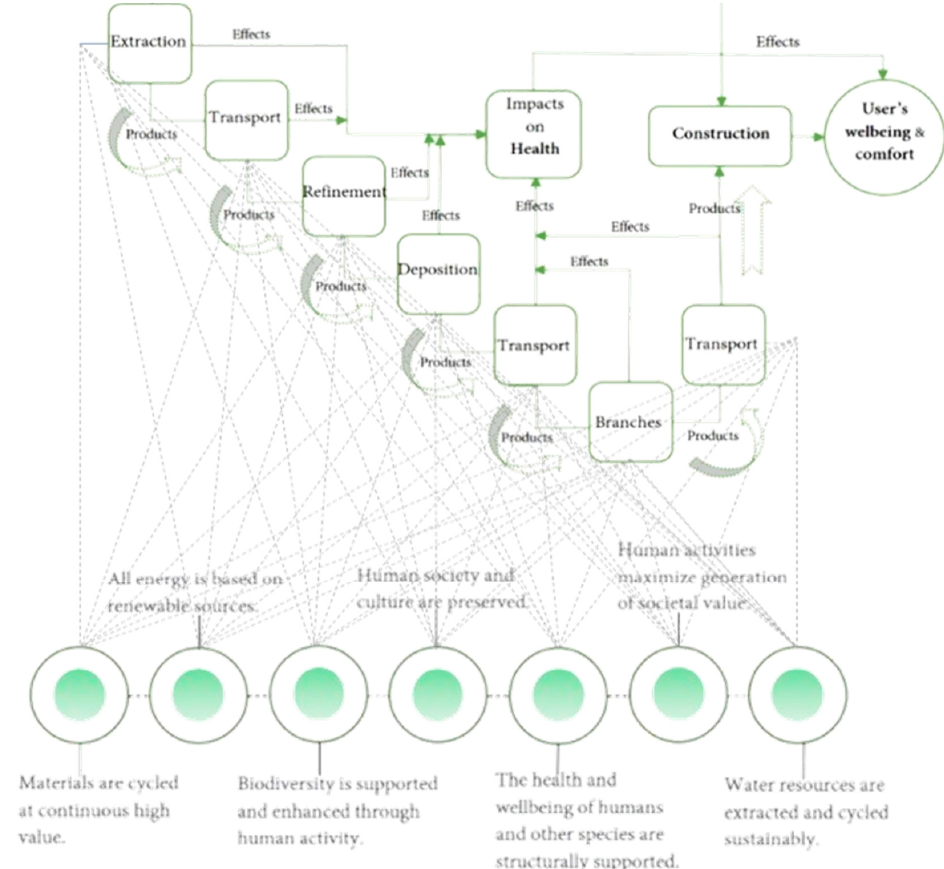
Figure 9. Principles of checking health. Similar to HCMS but based on circular economy pillars.